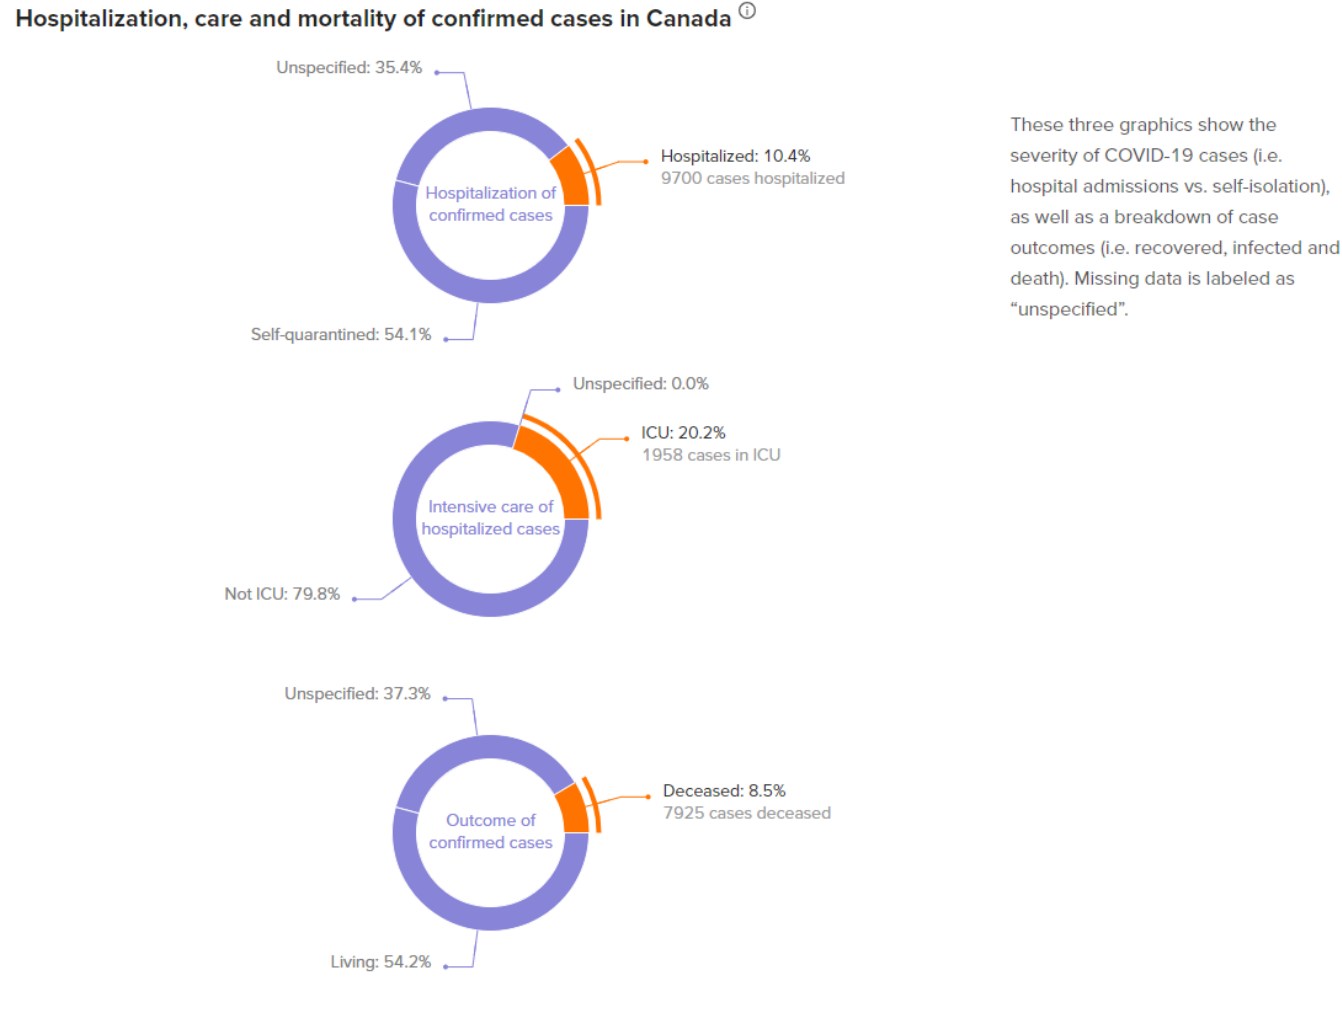
Figure 4: Severe Cases of COVID-19 in